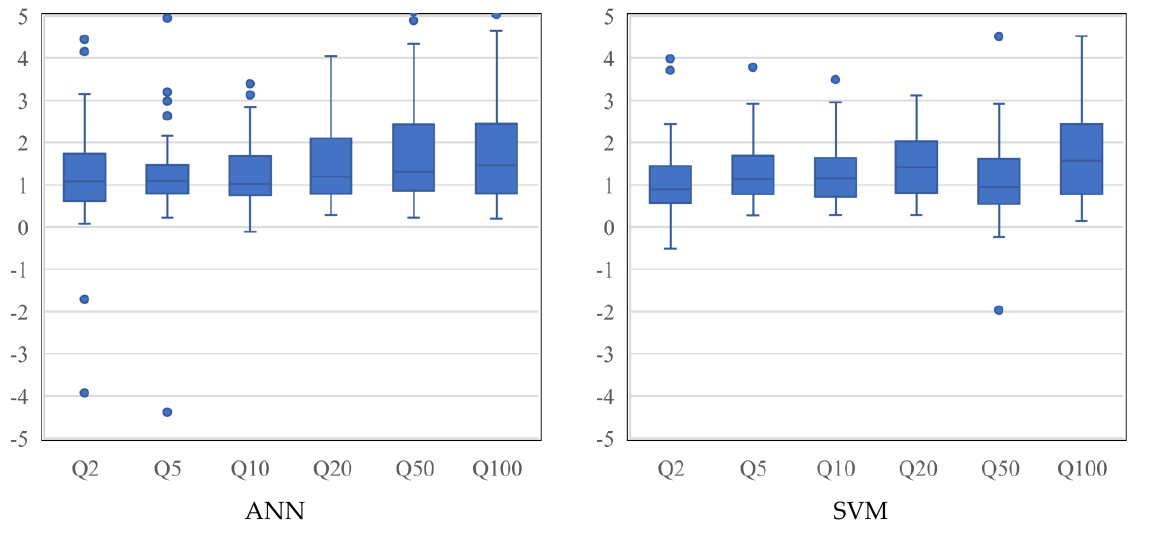
Figure 6. Boxplot of Q ratio values for the ANN and SVM methods. Y-axis presents Q ratio values.